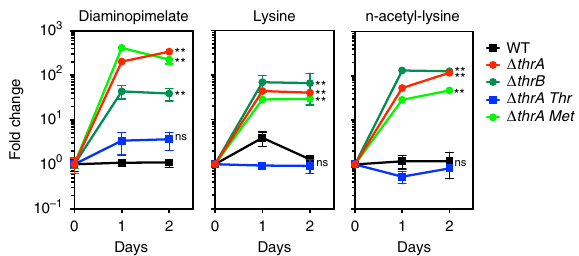
Fig. 4 Threonine but not methionine de fi ciency leads to lysine overload. To con fi rm that threonine de fi ciency alone is responsible for accumulation of lysine and intermediates, the endo-metabolome of the threonine auxotroph Mtb Δ thrB was determined and compared to Mtb Δ thrA . Accumulation of DAP, lysine and n-acetyl-lysine was detected in both strains. Only threonine but not methionine reversed lysine accumulation in Mtb Δ thrA . All values are the average of three biological replicates ( n = 3) ± s.d. (error bars depict standard deviation) and representative of two independent experiments. ** p -value < 0.01 in Student's t